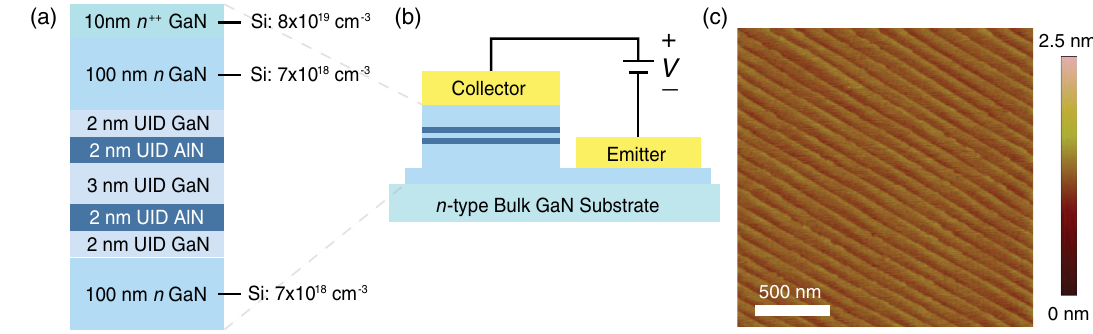
FIG. 1. (a) Schematic of the device structure and doping concentrations of the GaN = AlN double-barrier heterostructure grown by MBE on Ga-polar single-crystal GaN substrates. (b) Cross-section schematic diagram of a fabricated resonant tunneling diode with the collector and emitter metal contacts under forward bias. (c) Surface morphology of the as-grown RTD heterostructure with a rms roughness of ∼ 0 . 146 nm over a 2 × 2 μ m 2